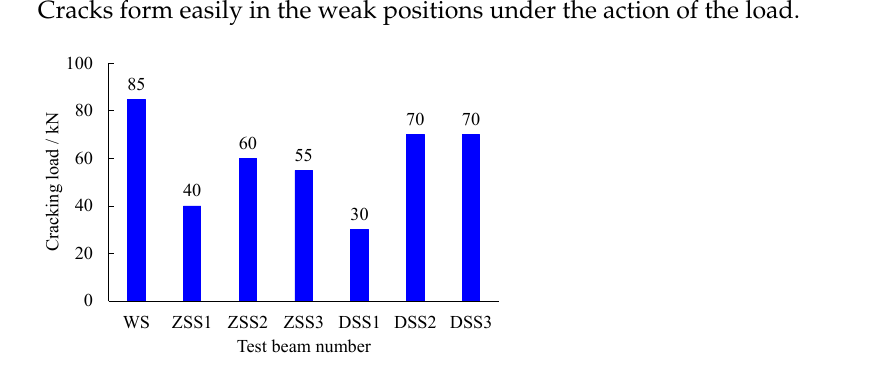
11 of 21 Figure 10. Strain distribution at mid-span section. ( a ) WS beam; ( b ) ZSS1 beam; ( c ) ZSS2 beam; ( d ) DSS2 beam; ( e ) DSS3 beam. 3.4. The Cracking Load and Ultimate Load